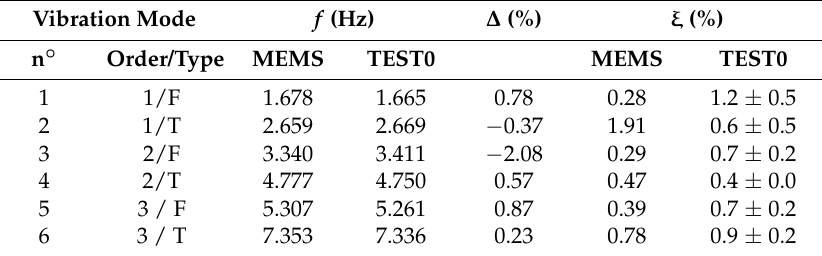
Table 3. EMA vibration frequencies and damping ratios for the first six fundamental modes, as obtained from MEMS measurements and past experiments (TEST0, see [44]). Key: F = flexural; T = torsional; ∆ = 100 × ( f − f MEMS TEST0 )/ f TEST0 .